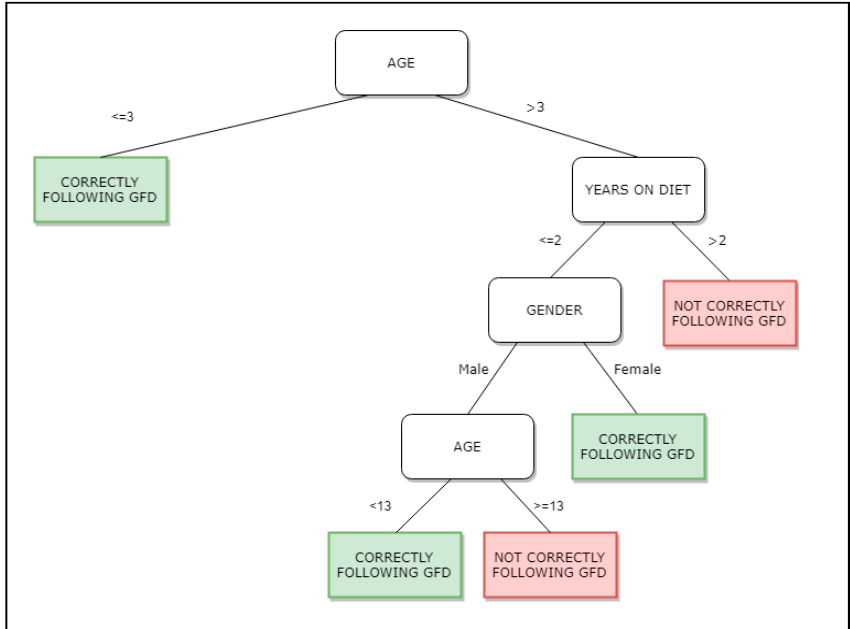
Figure 1. Decision tree obtained by use of the C4.5 algorithm. GFD stands for Gluten Free Diet.